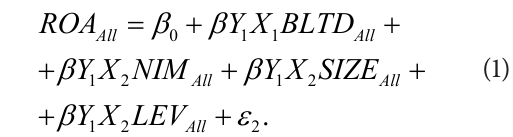
a table. ROA is used as a measurement of the opera- tional success of a bank since it may identify